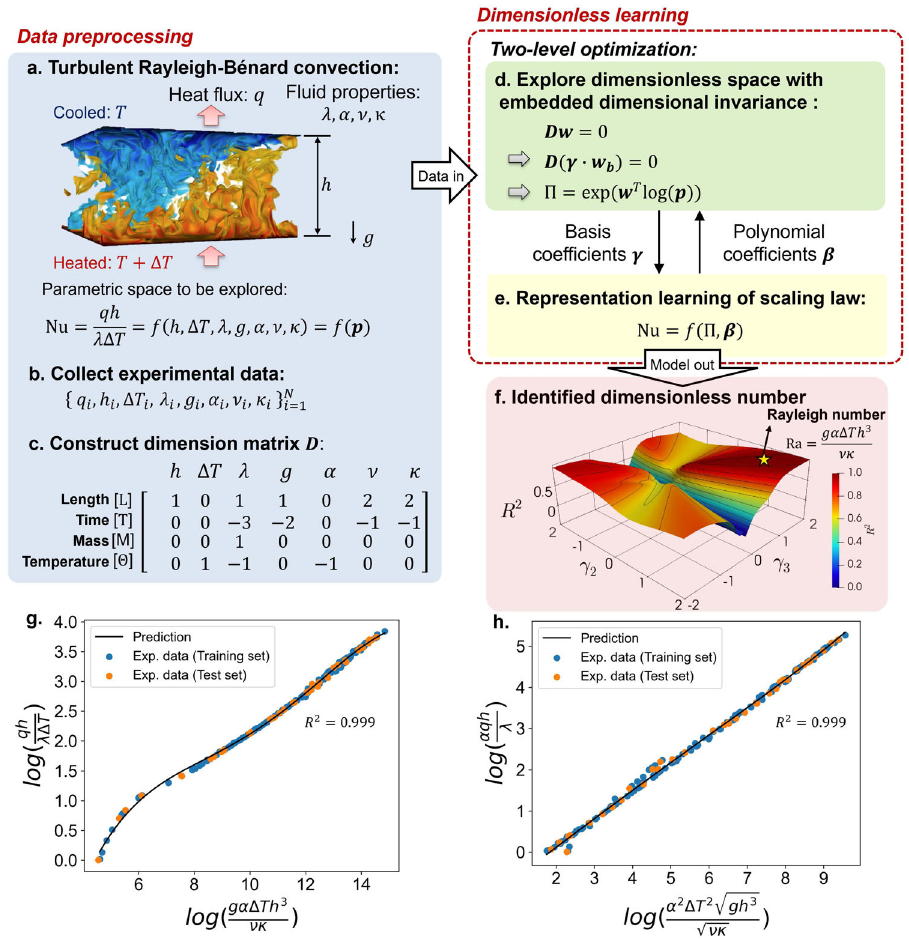
Fig. 1 | The proposed dimensionless learning demonstrated on turbulent Rayleigh – Benard convection. a A schematic of Rayleigh – Benard convection 49 with associated physical quantities. b Collected experimental measurements. c Constructeddimensionmatrix D oftheinputvariables. d The fi rstlevelofthetwo- level optimization scheme for training the coef fi cients γ with respect to the com- puted basis vectors. e The second level of the two-level optimization scheme for